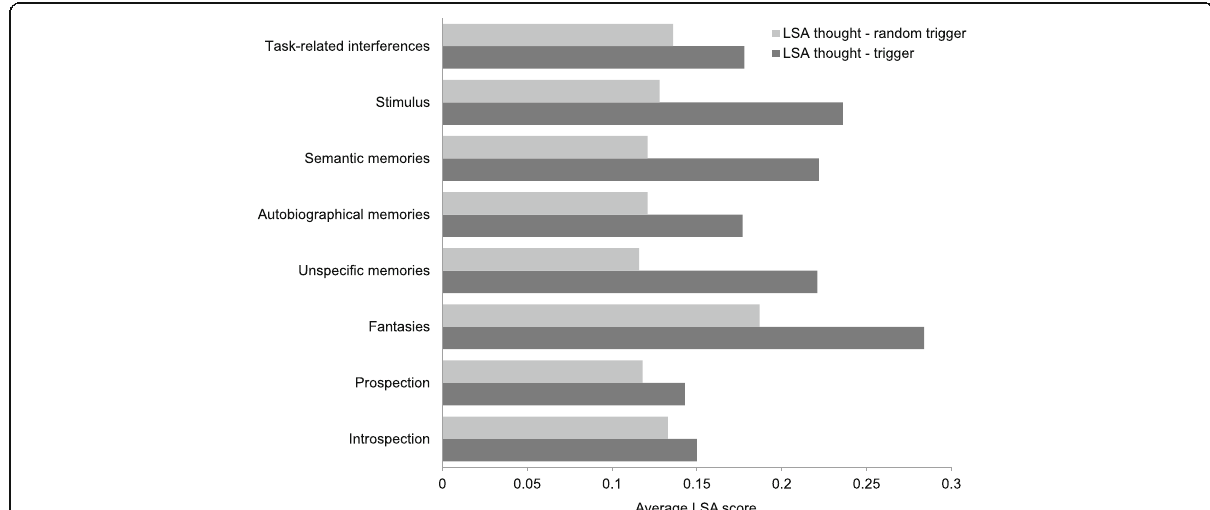
Fig. 3 Average LSA score for the relationship between the thoughts and triggers ( dark gray ) and thoughts and random triggers ( light gray ) at the thought-trigger level